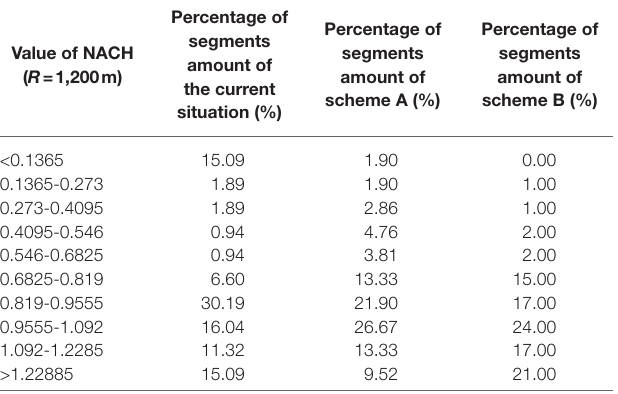
Percentage of segments amount of scheme A (%)